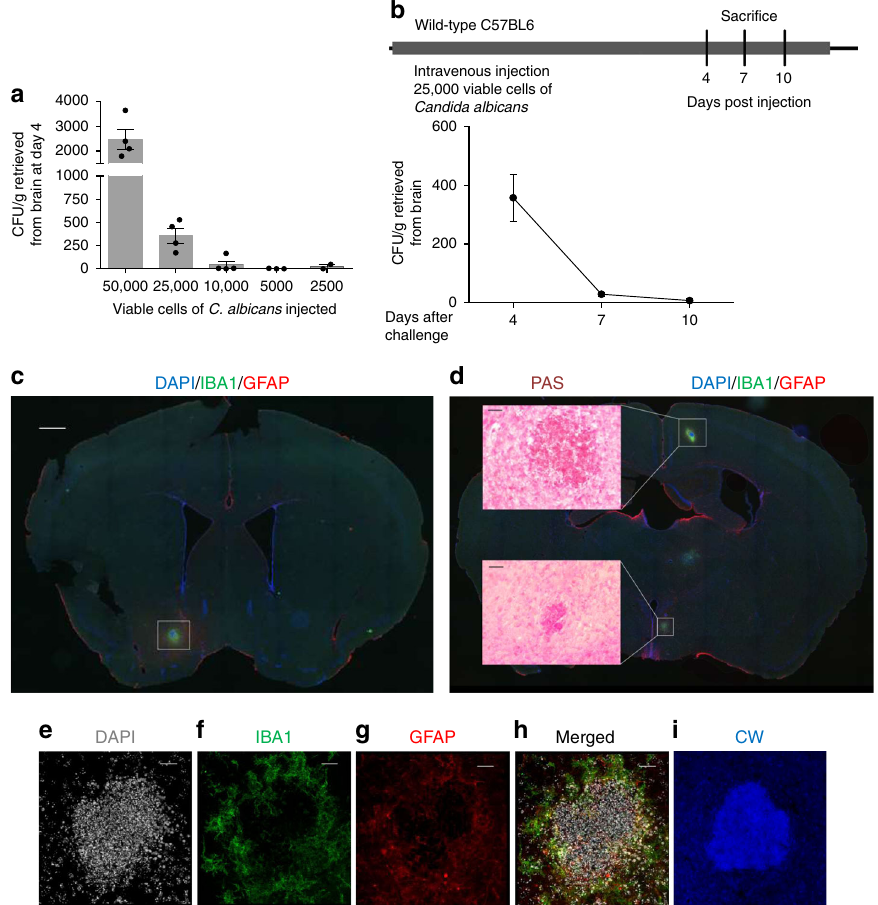
Fig. 1 Brain recovery of Candida albicans after intravenous injection. a Wild-type C57BL/6 mice were challenged once intravenously with the indicated doses of C. albicans and the mean colony forming units (CFUs) cultured from whole brain 4 days later were determined. b Clearance of C. albicans from brains of mice after i.v. challenge with 25,000 viable cells over 10 days. c , d Immuno fl uorescent staining of mouse brain 4 days post i.v. challenge. c Low- magni fi cation view of whole brain after staining with DAPI, IBA1, and GFAP (scale bar: 750 μ m) and d PAS staining on a consequent slide demonstrated granuloma-like structures (scale bar: 20 μ m). e – i Higher magni fi cation views of the boxed area in c stained with DAPI, IBA1, GFAP, and calco fl uor white (CW), respectively. The merged image is shown in h . (Scale bar: 20 μ m. n = 4 in b ). Data are representative of three ( a , b ) and six ( c – i ) independent